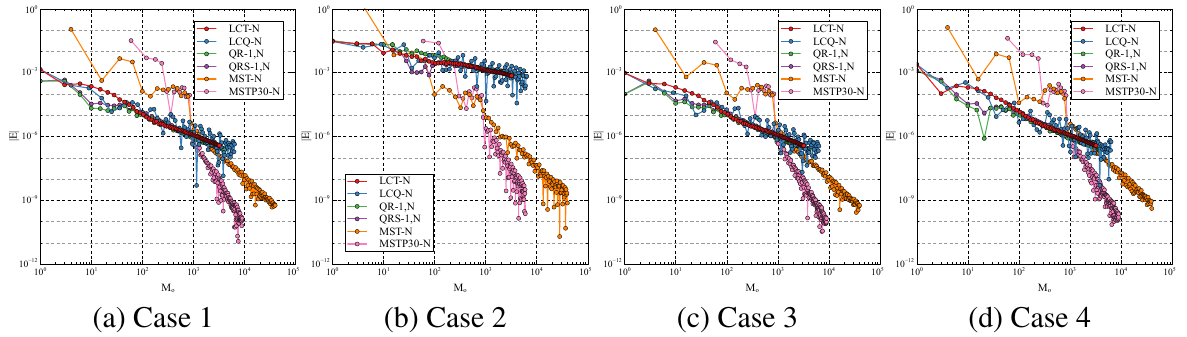
Figure 4: Point-wise uncollided scalar flux errors obtained by traditional and our new quadrature types with increasing number of discrete ordinates per